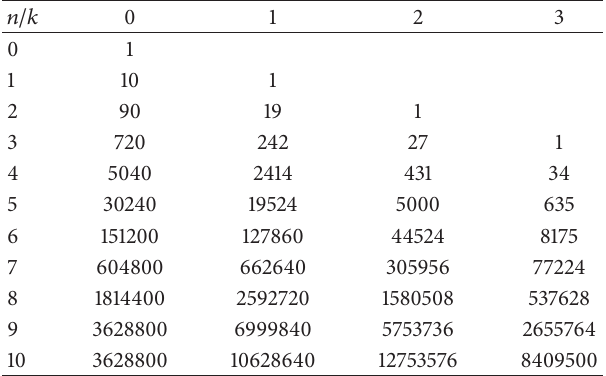
Table 2: Values of 𝑠 10 (𝑛, 𝑘) .